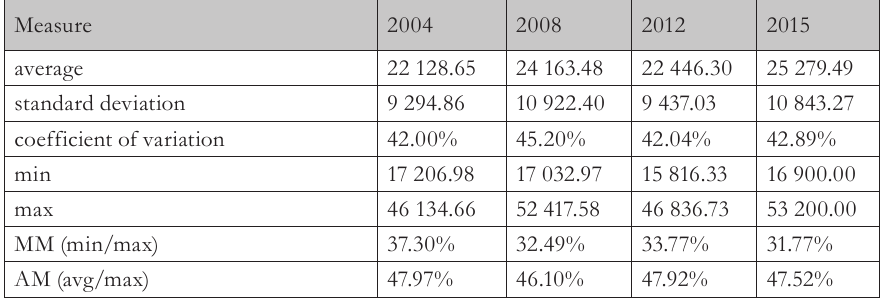
Tab. 3 – Selected measures describing the level of the regional GDP pc level and its diversi- fication in the Czech Republic in selected years [data in EUR according to PPS (2015=100)]. Source: Own calculations based on Eurostat database (access: